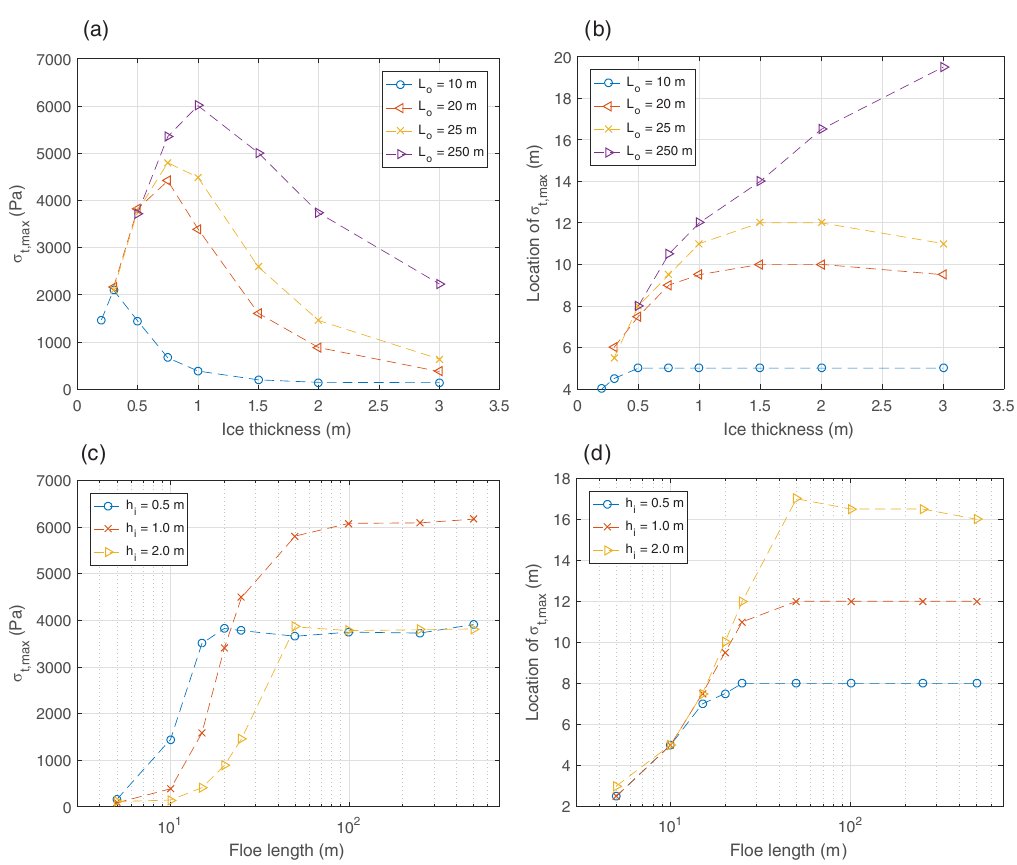
Figure 5. Simulated maximum tensile stress σ t , max (a, c) and location (distance from the up-wave ice edge) at which it occurs (b, d) for different ice thickness h i and floe length L o values; open-water wavelength is L w , 0 = 42m. Note that the x axis in panel (c, d) is